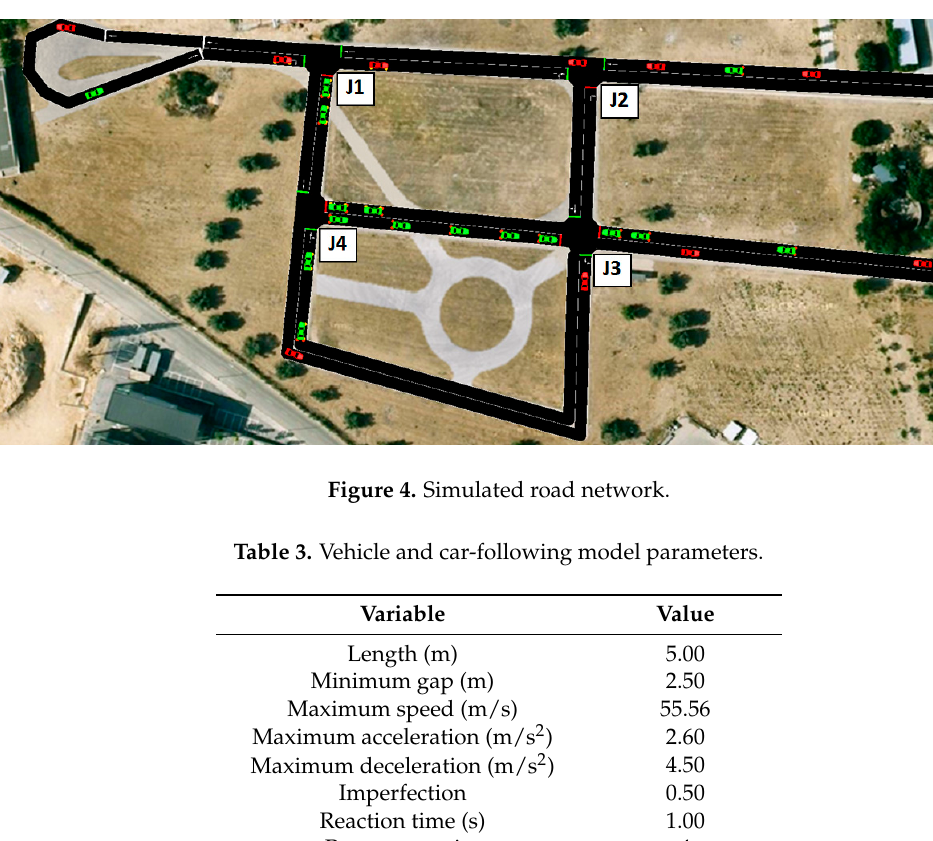
Figure 5. Initial timing of J3 ( a ), initial timing of J1, J2 and J4 ( b ).